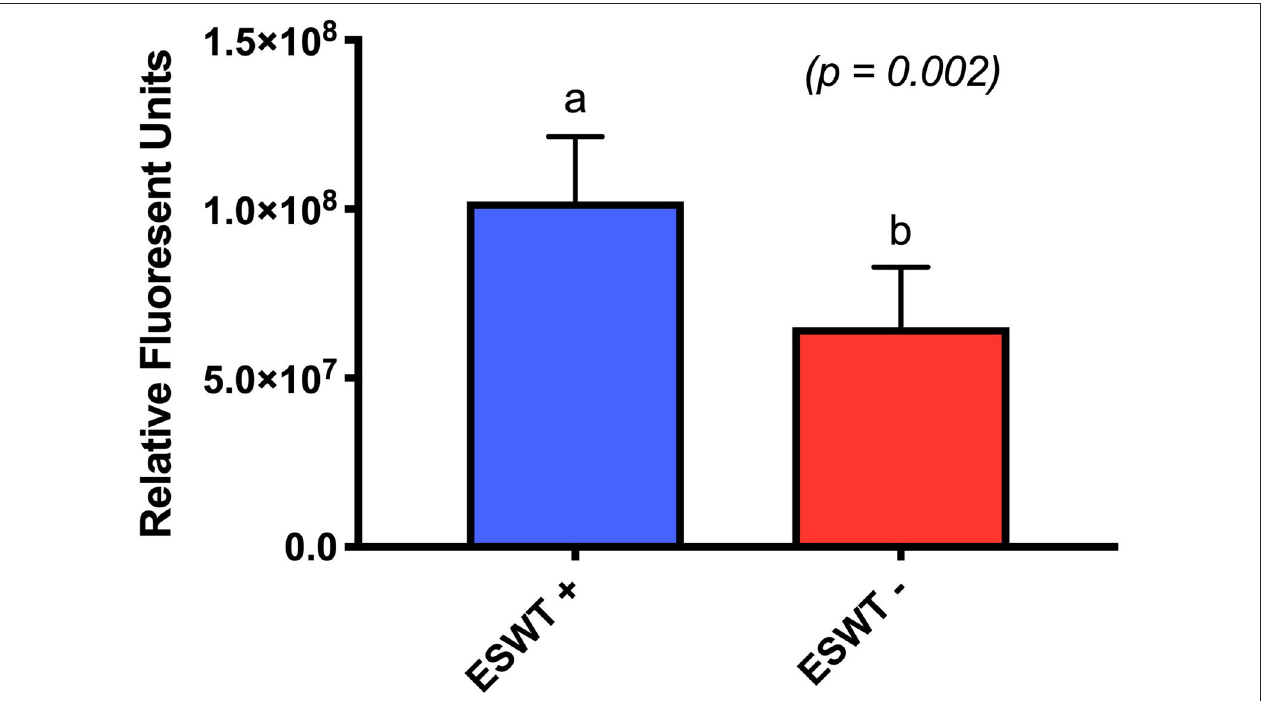
FIGURE 4 | Metabolic activity. Relative fluorescent units for treated (ESWT + ) and untreated (ESWT–) equine CB-MSCs. Results are shown as mean and CI 95% ( p = 0.0002). Values with different letters are statistically different.